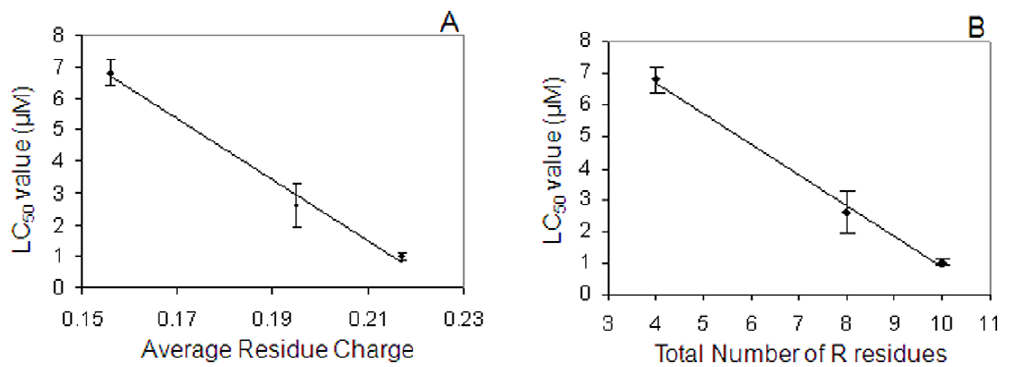
Figure 7. Protein properties affecting the antifungal activity of the ReHst constructs. Relationship between the average residue charge (A) or the number of arginine residues (B) and the LC 50